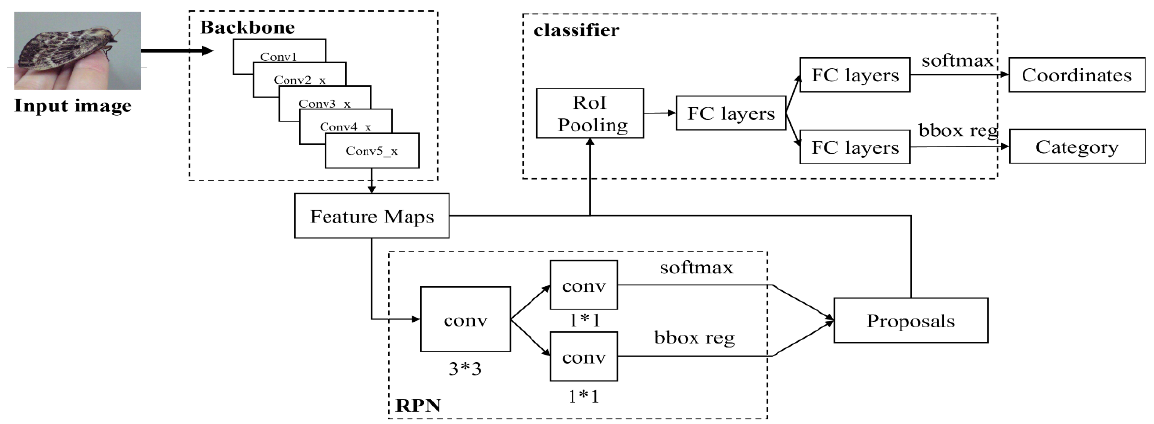
Figure 4. Design for pine pest detection using the Faster R-CNN model.